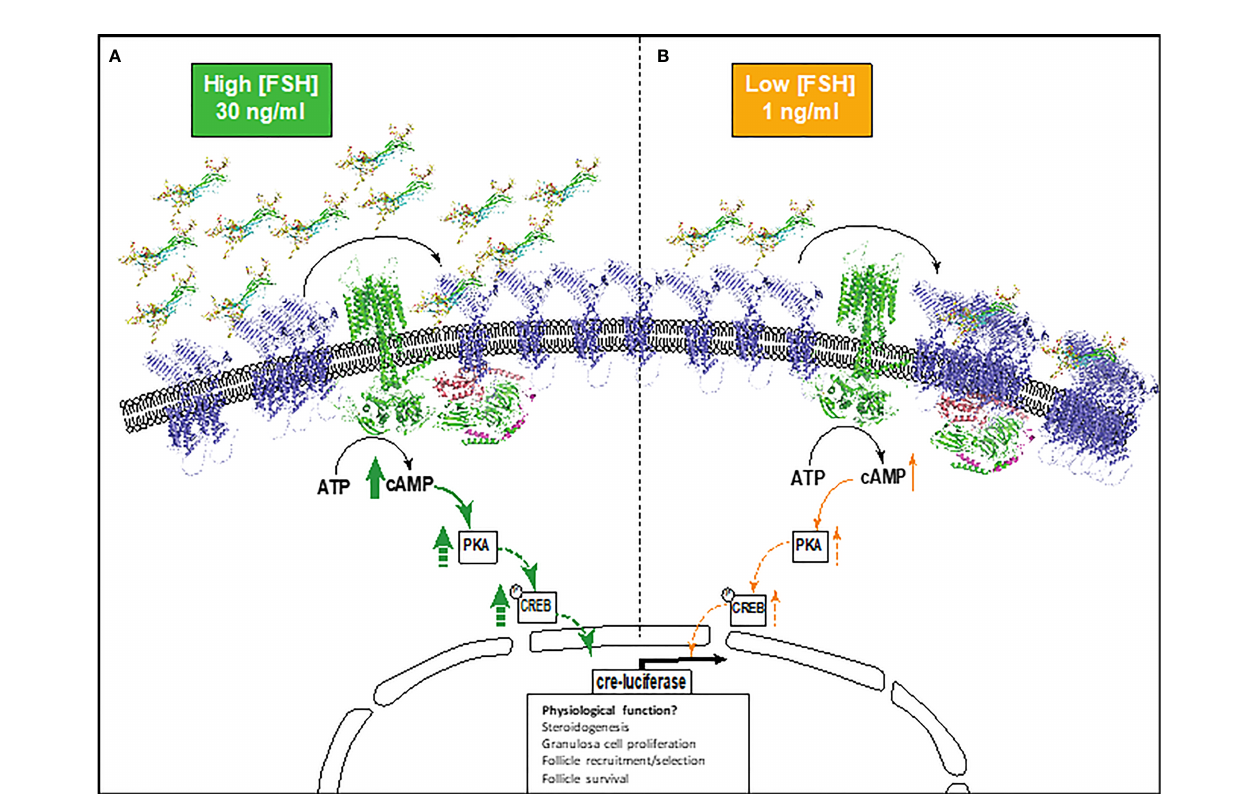
FIGURE 5 | Schematic depicting the proposed model of FSHR monomer/oligomer-dependent modulation of cAMP signaling. (A) Higher physiological concentrations of FSH glycoforms (30 ng/ml), mediates the re-organization of FSHR oligomers into monomers at the plasma membrane, activating the G a s-adenylyl cyclase-cAMP-PKA-CREB pathway and resulting in high cre-responsive gene activation. (B) Lower physiological concentrations of FSH glycoforms (1 ng/ml). FSHR monomer-homomer populations remain quiescent or further associate to promote FSHR oligomerization. This results in lower levels of cAMP and cre-responsive gene activation. This may have implications on granulosa cell functions including steroidogenesis, granulosa cell proliferation, follicle recruitment and selection, and follicle survival. Dashed arrows indicate proteins in the cAMP pathway that were not investigated, but are concordant with published literature. FSH glycoforms are modelled, FSHR is represented by an alpha-fold model (blue) and structural depiction of adenylyl cyclase